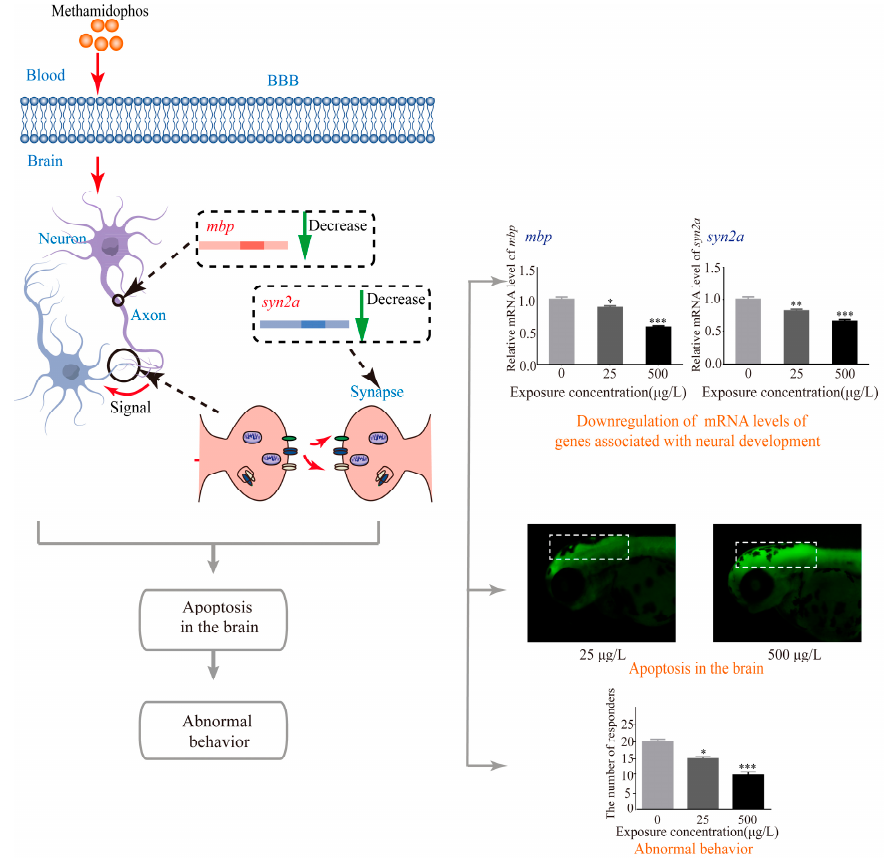
Figure 6. The developmental neurotoxicity of methamidophos in embryo-larval stages of zebrafish. * p < 0.05; ** p < 0.01; *** p < 0.001.